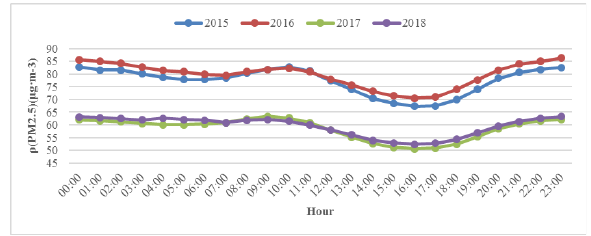
Figure 2. Hourly PM2.5 concentration in “2+26” cities